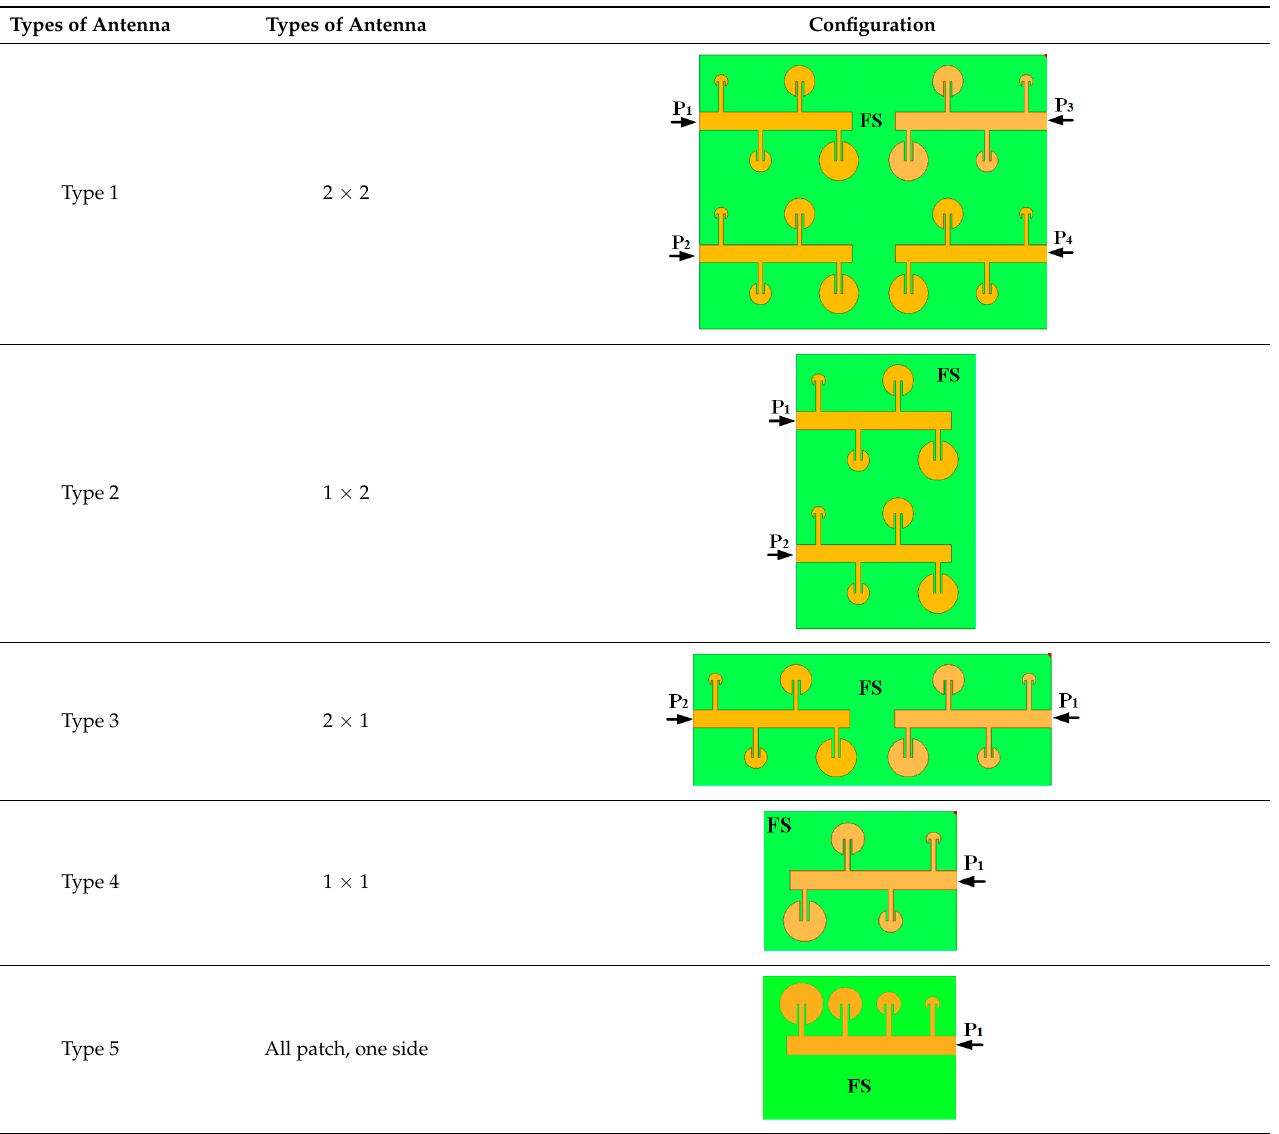
Table A1. Types of MIMO antenna Configuration.